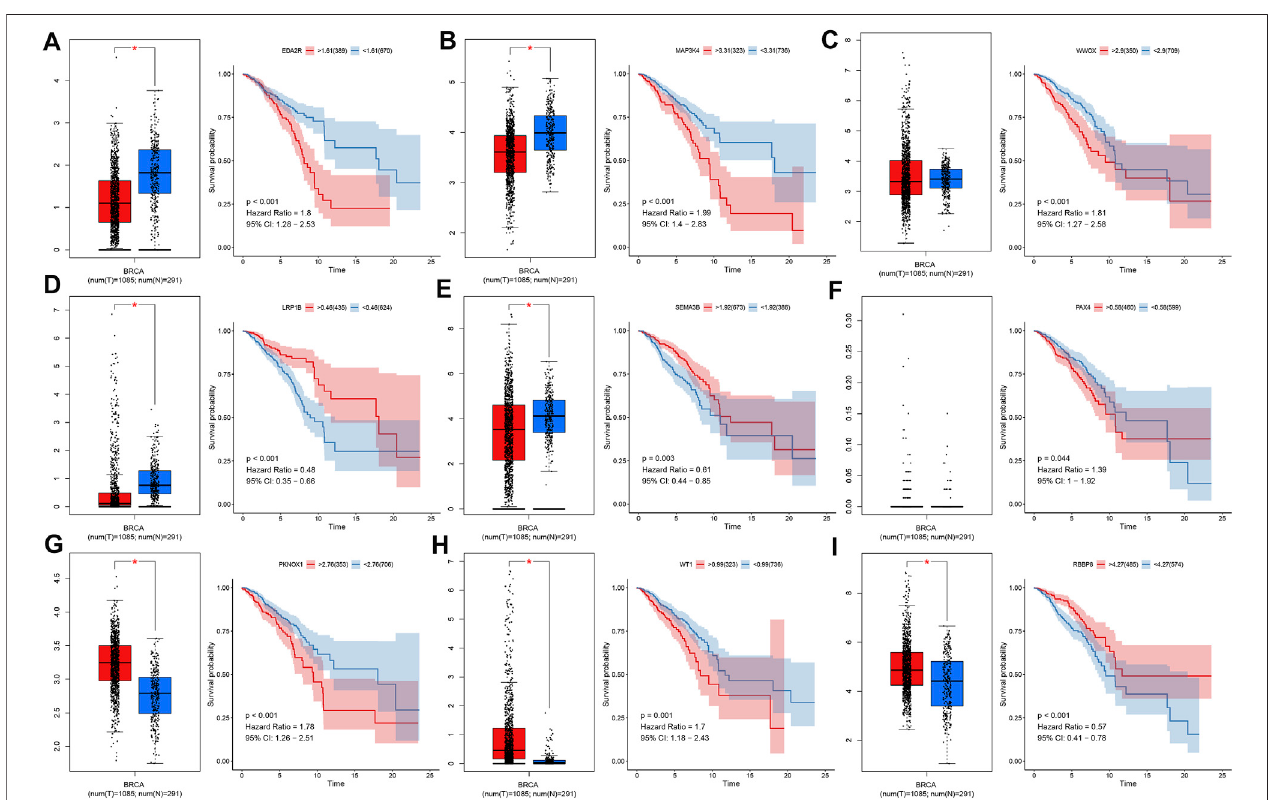
FIGURE 4 | Expression and survival analysis of each characteristic TSG in the prognostic classi fi er across breast cancer in TCGA dataset. (A – I) The mRNA expression of (A) EDA2R, (B) MAP3K4, (C) WWOX, (D) LRP1B, (E) SEMA3B, (F) PAX4, (G) PKNOX1, (H) WT1, and (I) RBBP8 in 1,085 breast cancer tissues and 291 normal breast tissues as well as Kaplan – Meier curves and log-rank tests of their high and low expression groups. * p -value < 0.05.